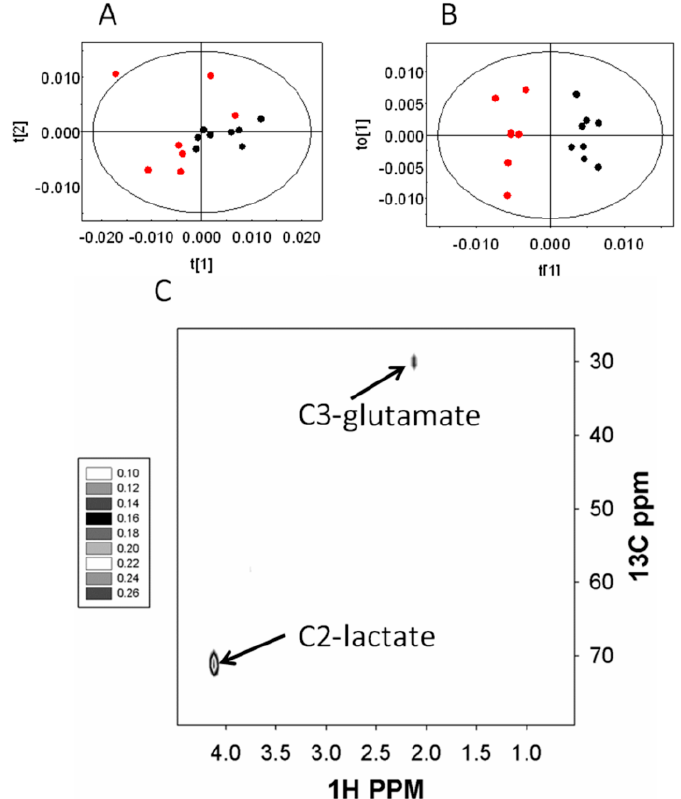
Figure 4. The changes in the labeling patterns from 2 13 C-glucose in the brain of early stage infection (~1% parasitemia) and uninfected control mice. ( A – C ) hydrophilic extract brain. ( A ) PCA score plot and ( B ) OPLSDA score plot; black—early stage, and red—control animals. ( C ) relevant OPLSDA loadings plot.